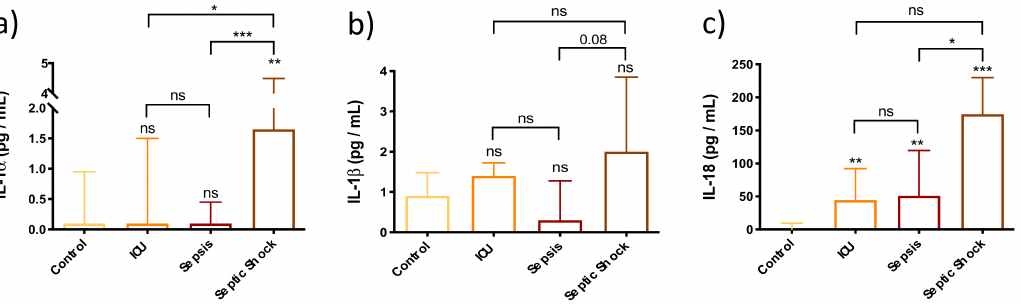
Figure 2. Bar graph (Median ± IQR) of circulating levels of pyroptosis-related cytokines in control group, ICU, sepsis and septic shock patients. ( a ) Circulating levels of IL-1 α ; ( b ) Circulating levels of IL-1 β ; ( c ) Circulating levels of IL-18. Each sample was measured in duplicate. Groups were compared by the Kruskal–Wallis test with post hoc Dunn’s multiple comparison test. ns = non-significant. p value; * p < 0.05; ** p < 0.01; *** p < 0.001. The lines at the top of the box plots indicate differences between compared conditions. The number of subjects analyzed were as follows: control ( n = 10); intensive care unit (ICU) ( n = 5); sepsis ( n = 10); septic shock (SS) ( n =